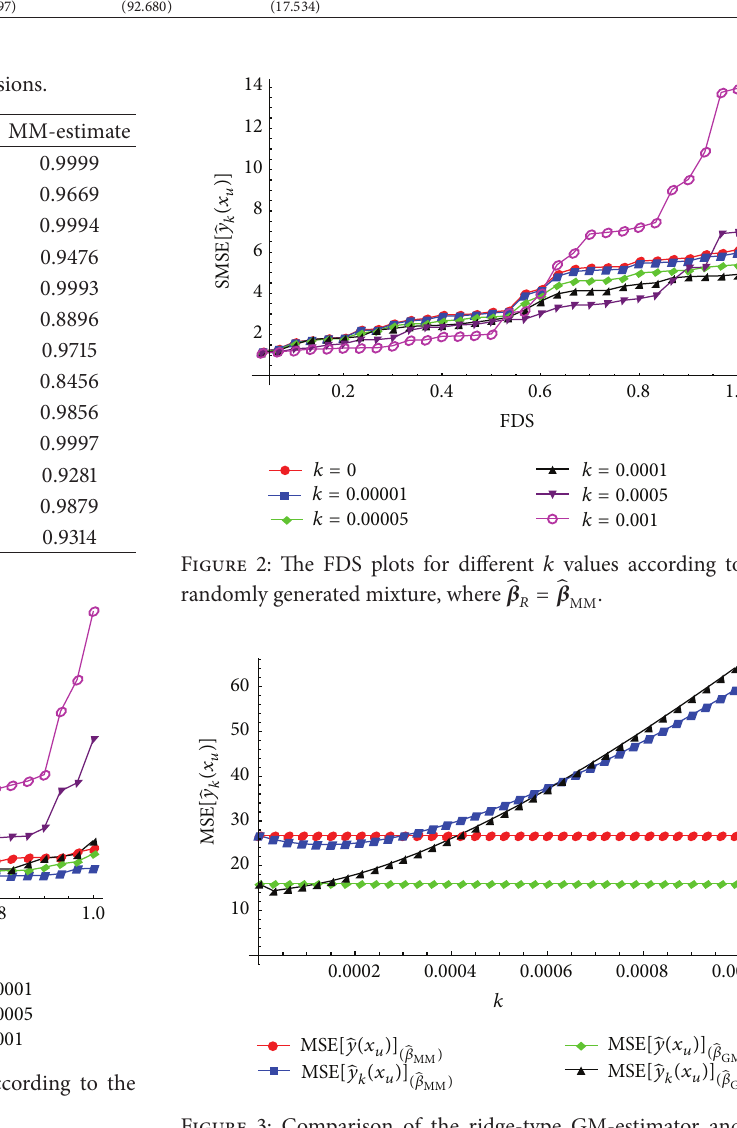
Figure 3: Comparison of the ridge-type GM-estimator and the ridge-type MM-estimator under MSEP